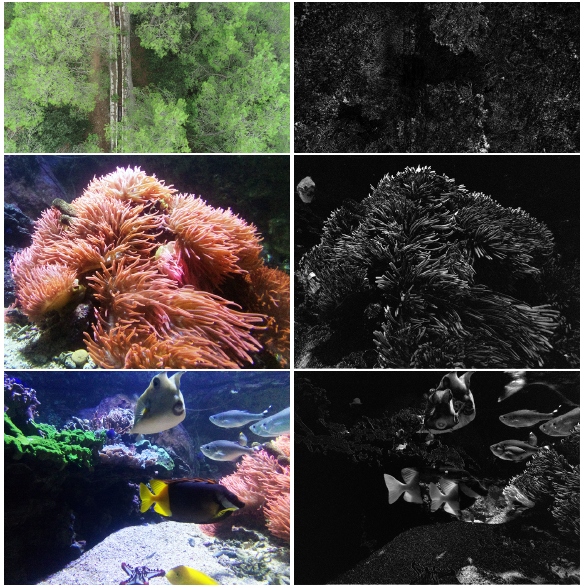
Figure 1. Sensitivity to dynamism for several typical scenes of an acquisition campaign: an image of a scene (left) and its displacement map (right) calculated over an interval of 1s. The magnitude of the displacements is up to several tens of